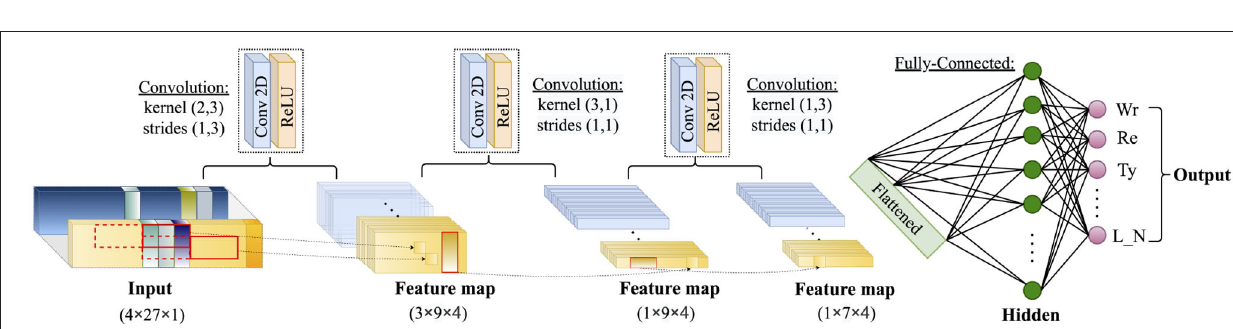
Frontiers in Digital Health |